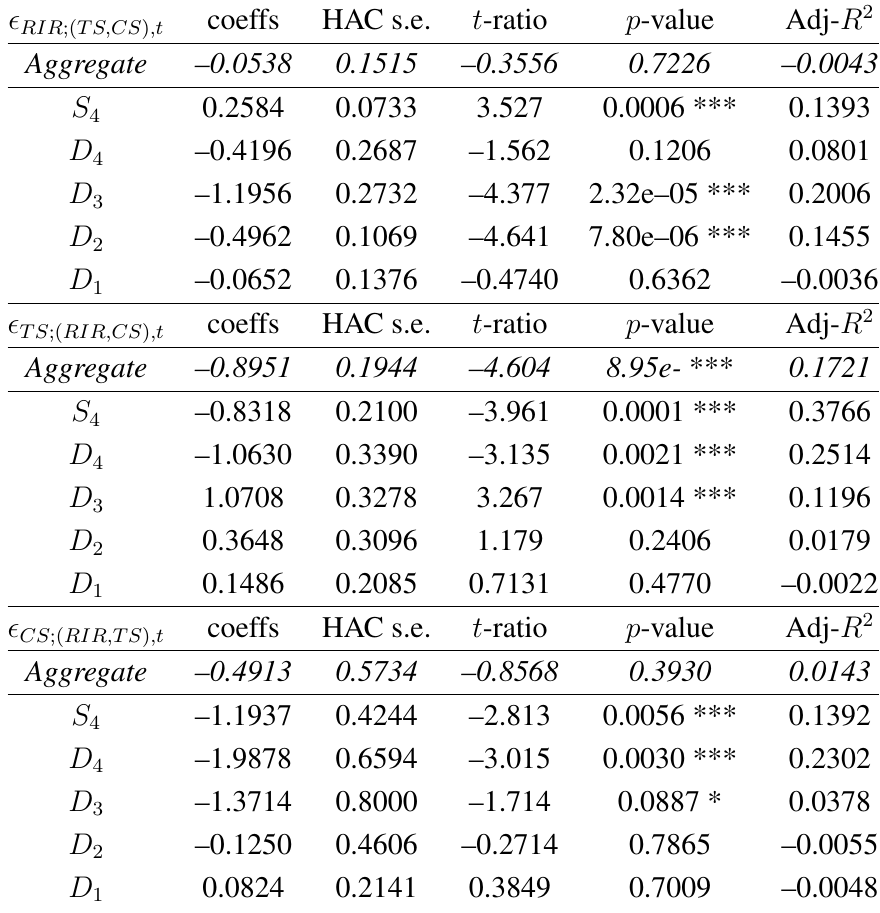
Table 5. Scale-by-Scale “double residuals” OLS